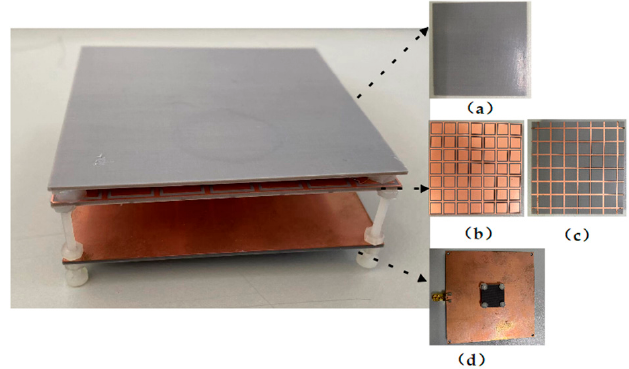
Figure 17. F-P antenna physical diagram . ( a ) PRS top layer. ( b ) PRS bottom layer upper surface. ( c ) PRS bottom layer lower surface. ( d ) Feed antenna.